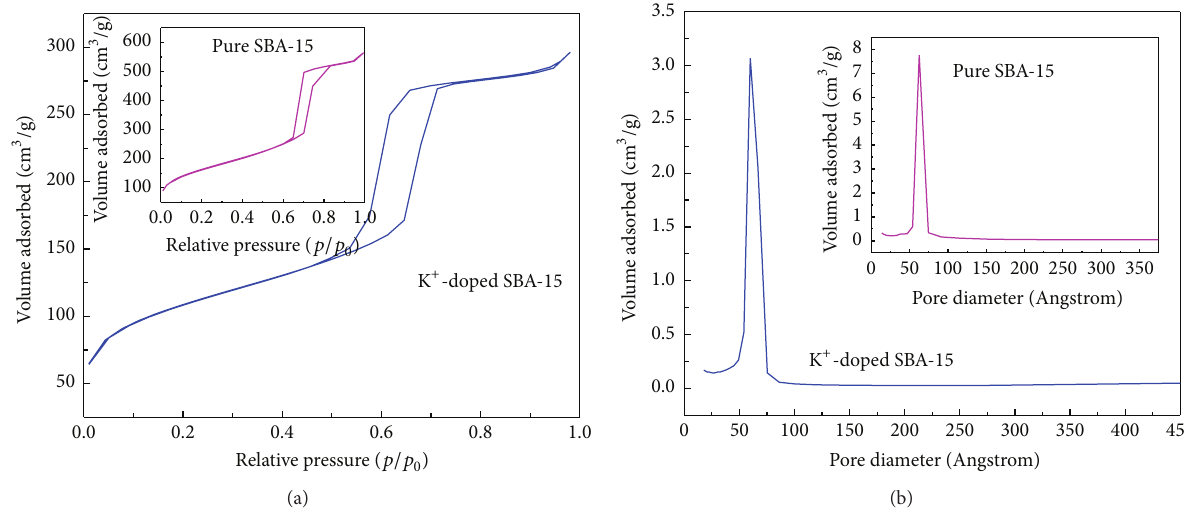
Figure 5: (a) Nitrogen adsorption-desorption isotherms. (b) Pore size distribution of pure and K + -doped